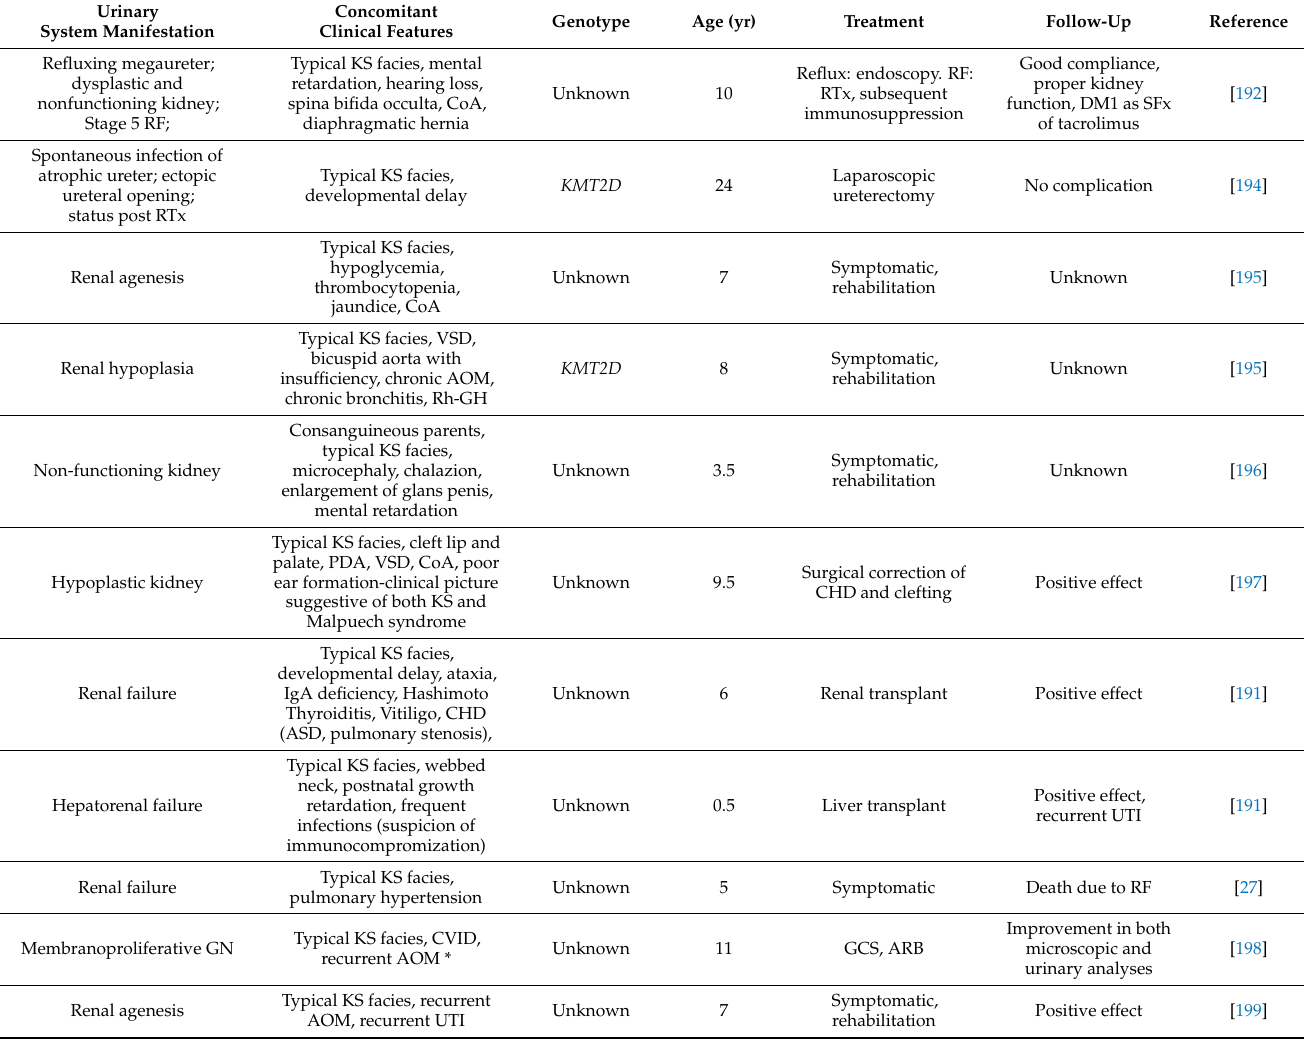
Table 7. Rare Urinary System manifestations in KS patients. AOM—Acute Otitis Media. ARB—Angiotensin Receptor Blocker. CoA—Coarctation of Aorta. CHD – Congenital Heart Disease.DM1—Diabetes Mellitus Type 1. GH—Growth RTx—Renal Transplantation. SFx—Side effects. VSD—Ventricular Septal